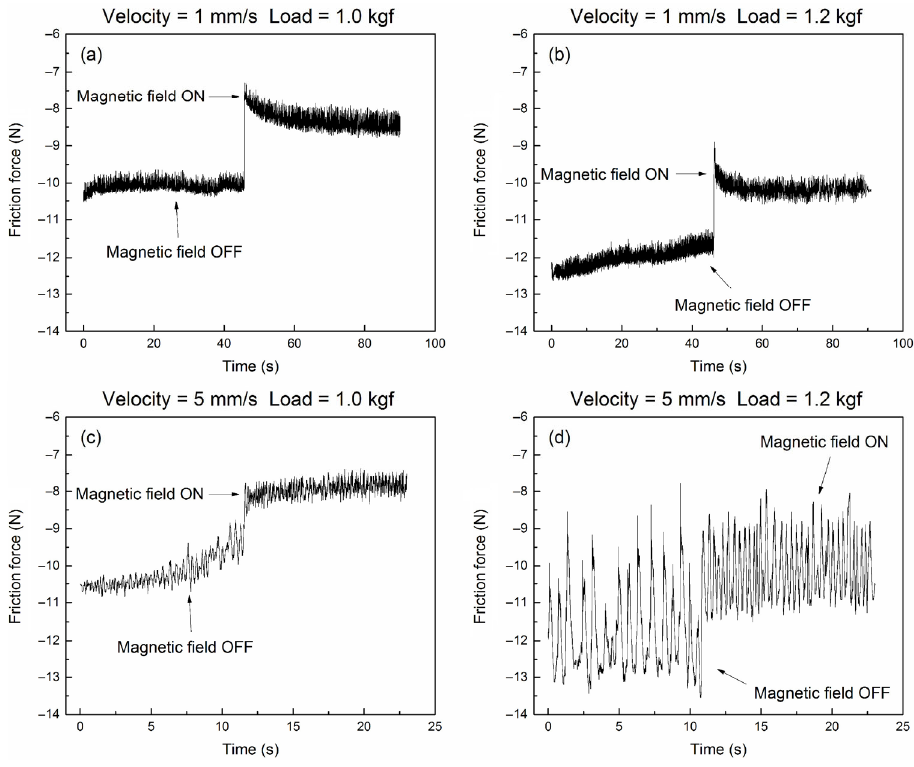
Fig. 7 Results of friction force tests: (a), (b) velocity 1 mm/s, load 1.0 and 1.2 kgf, respectively; (c), (d) velocity 5 mm/s, load 1.0 and 1.2 kgf,